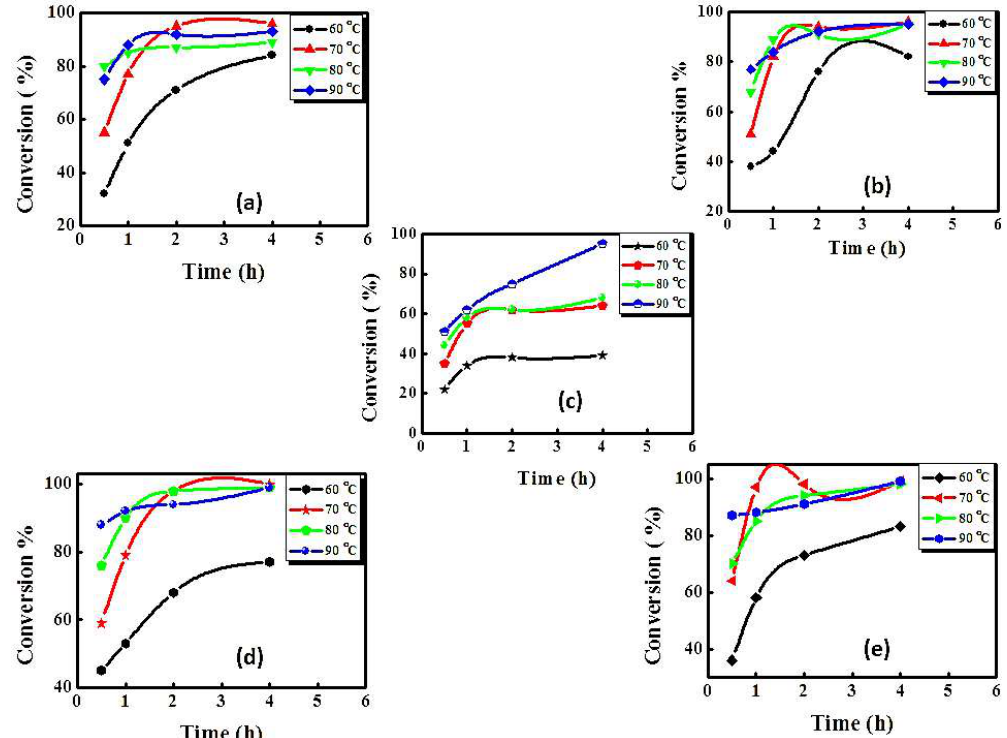
Figure 4. Oxidation of benzyl alcohol (1.0 mmol) catalyzed by the prepared Schiff base-M(II) complexes and their respective metal oxide (MO) (0.03 mmol) using aqueous H 2 O 2 (3.0 mmol) in dimethylsulfoxide (DMSO) at designated temperatures using: ( a ) ahpvCu, ( b ) ahpnbCu, ( c ) ahpvNi complexes, ( d ) CuO, and ( e ) NiO.